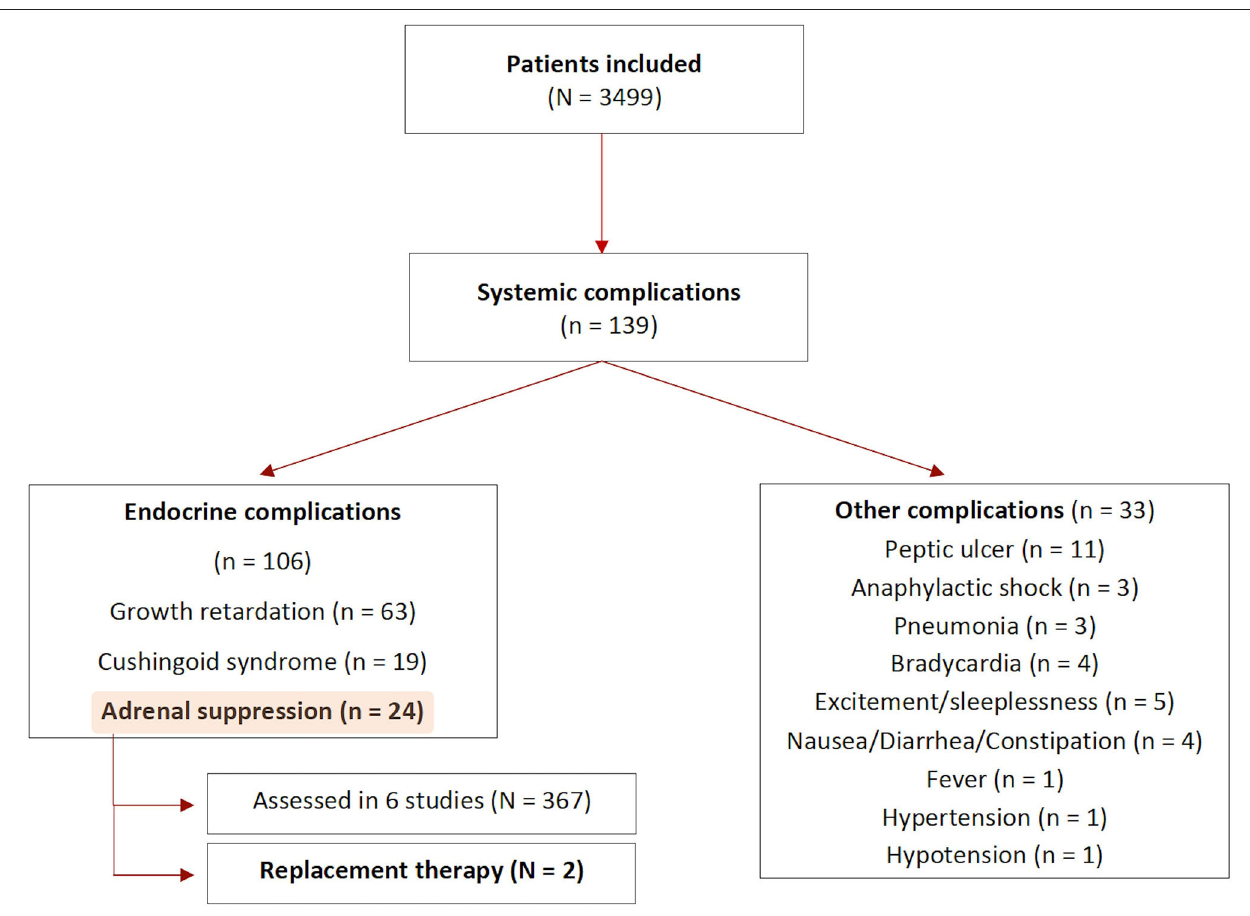
Frontiers in Pediatrics |